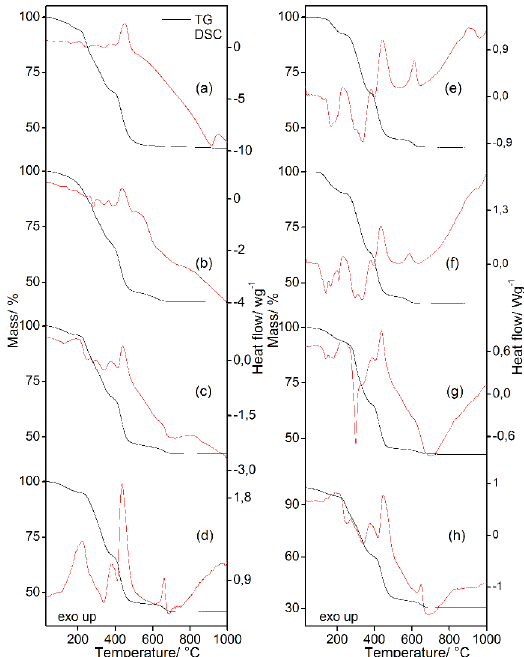
Figure 1. Simultaneous TG-DSC curves of the complexes: (a) Tb(L) ∙1.5H O, (b) Dy(L) 3 2 (e) Tm(L) ∙2H O, (f) Yb(L) 3 2 Y(L) ∙1H 3 2